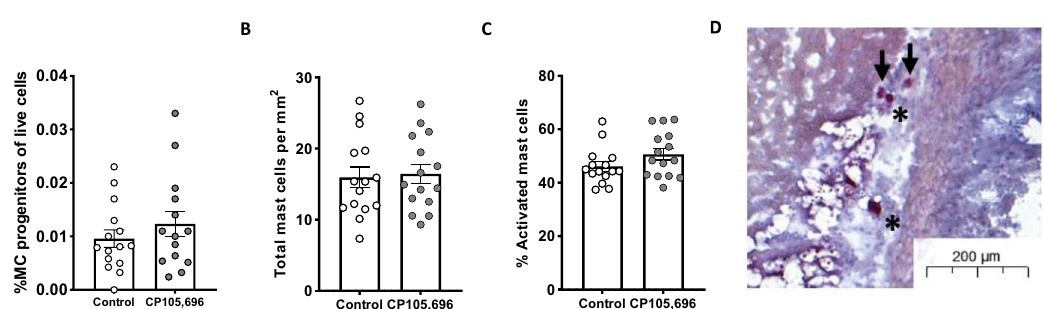
Control CP105,696 Figure 5. Mast cell accumulation in advanced atherosclerotic plaques ( A ) BLT1-antagonism did not affect the percentage of CD34 + Lin - CD127 - CD16/32 + CD117 + FCεRI + mast cell progenitors in blood. ( B ) The total number of mast cells per mm 2 perivascular tissue of the aortic root tissue and ( C ) the percentage of activated mast cells did not differ between the CP105,696 treated and control group. ( D ) Representative image of mast cell staining in the aortic root section. Asterix indicates resting mast cells, arrows indicate activated mast cells. n = 14–15 per group. Data represent mean ±